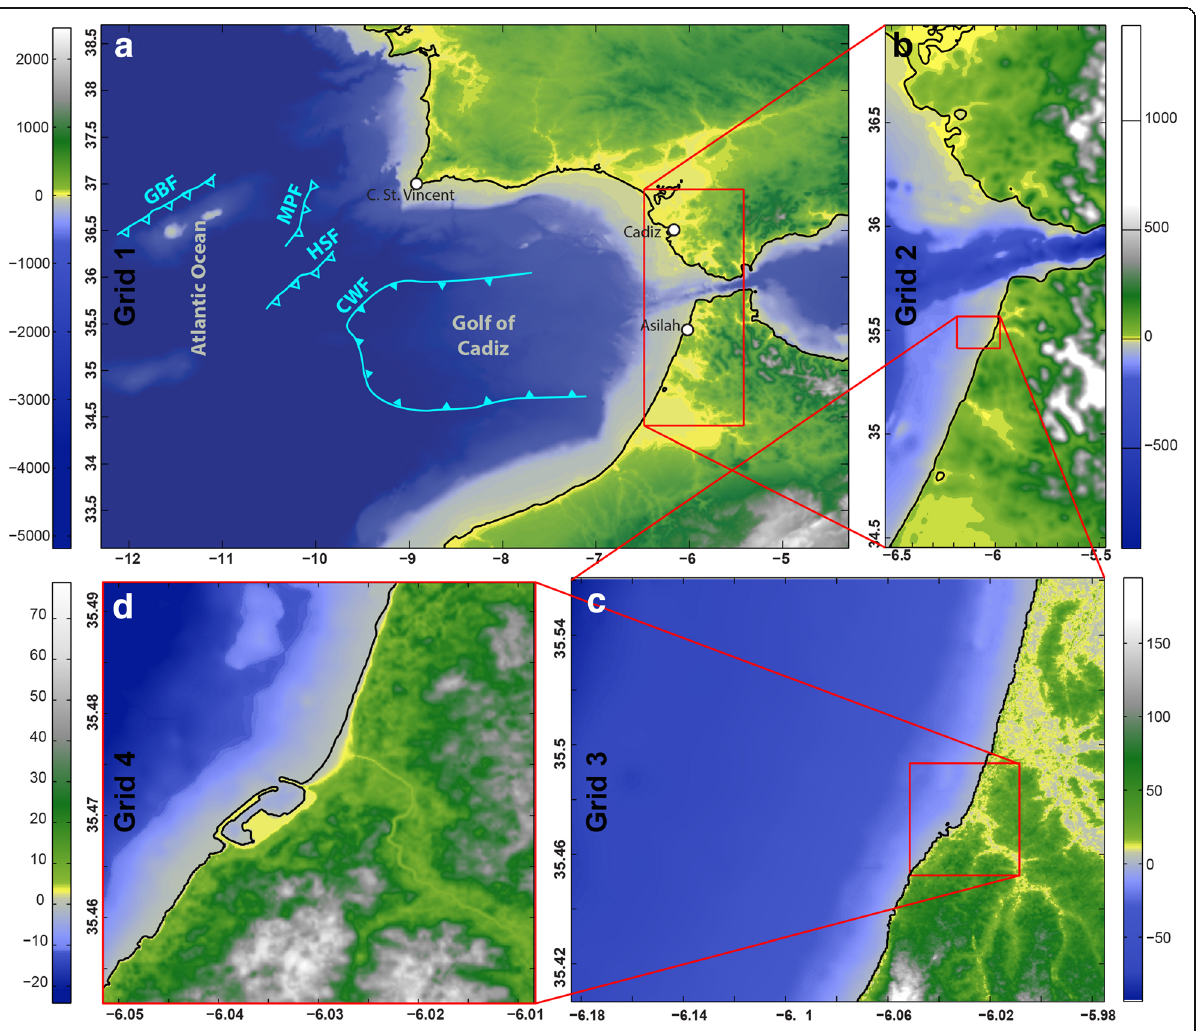
Fig. 2 Tsunami scenario and nested grids system, ( a ) Parent grid of 640-m resolution and location of the typical faults (TFs) used for tsunami modeling in the SWIM. Dextral reverse faults: Gorringe Bank fault (GBF), Marques de Pombal fault (MPF), Horseshoe Fault (HSF); subduction slab: